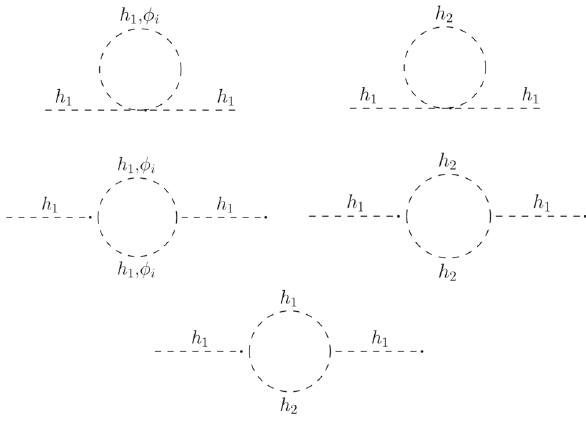
Fig. 1 The one-loop diagrams leading to the m 2